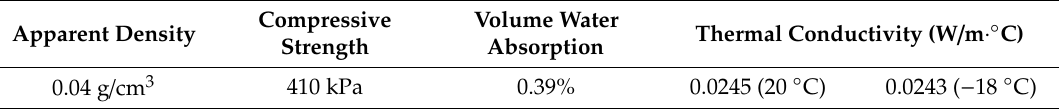
Table 1. Parameters of the extruded polystyrene (XPS)